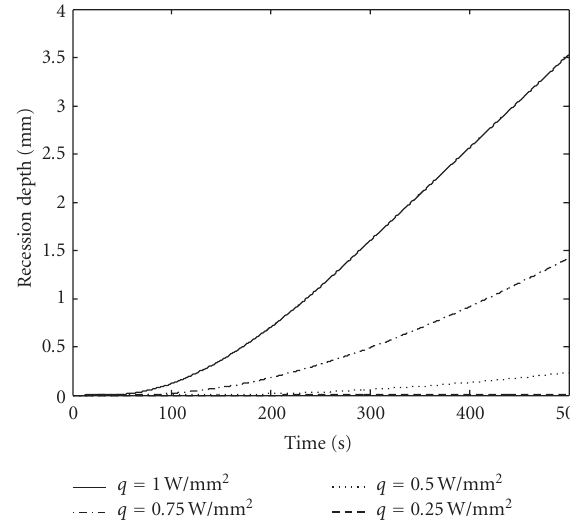
Figure 6: Surface temperature versus time ( q = 0 . 45W / mm 2 , u = 19000cm / s) .